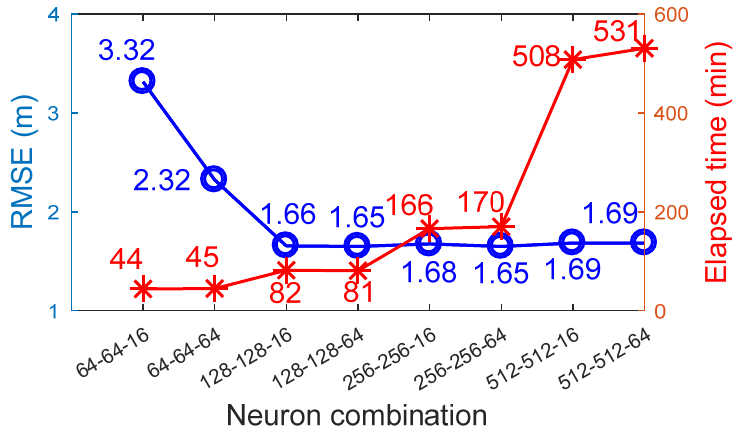
Figure 14. Variation of the training error and elapsed time for different neuron number combinations. The blue and green lines represent the change of the RMSE and elapsed time, respectively.